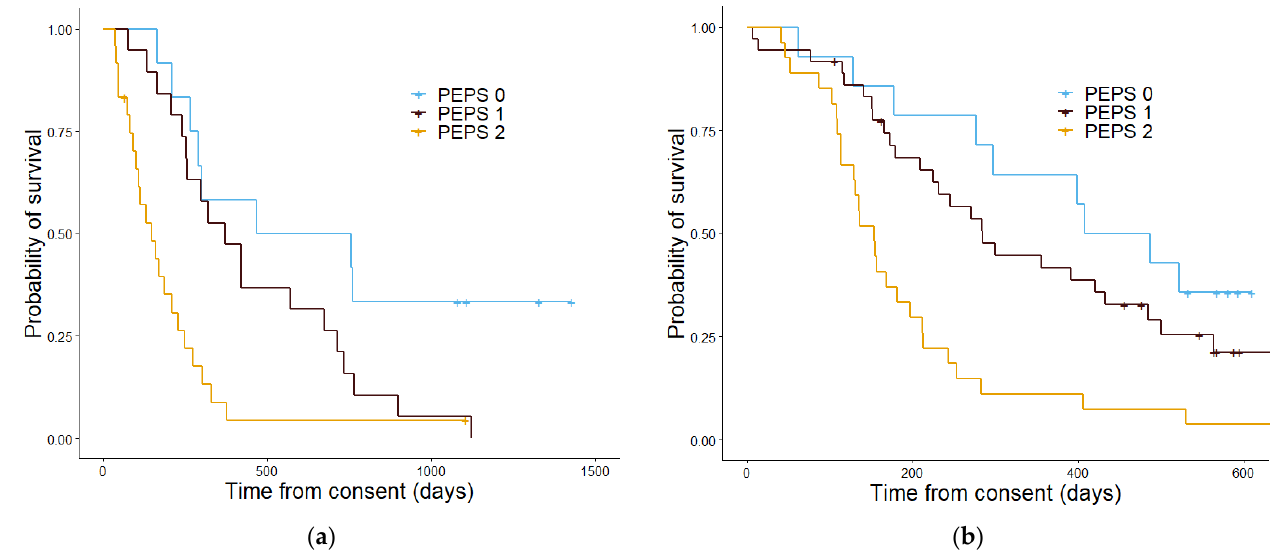
Figure 7. Kaplan–Meier curves showing the overall survival determined by the proteomics enhanced performance status in the discovery cohort ( a ) and the validation cohort ( b ). In the discovery cohort ( a ) patients with a PEPS score of 0 had a median estimated overall survival in days of 612, patients with a PEPS score of 1 had an estimated median overall survival of 371 days and patients with a PEPS score of 2 had a median overall survival of 148 days. The p value was 5.3 × 10 57 . In the validation cohort ( b ) the median overall survival estimate in days patients with a PEPS of 0 was 486, for PEPS score 1 was 298, and for PEPS score 2 was 153. The p value was 7.4 × 10 − 7 . The difference scores were assessed using receiver operatic characteristics curves (Figure 8). The false positive rate, or specificity, was plotted against the true positive rate, or sensitivity. Wellness Score had an AUC of 0.755 with a p value of 0.043 in the discovery